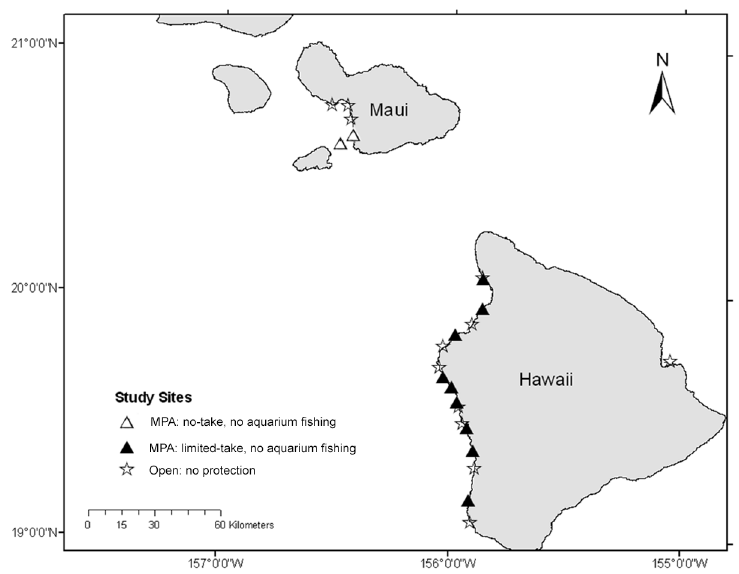
Figure 1. Map of study sites inside and outside protected areas in West Hawai’i and Maui.